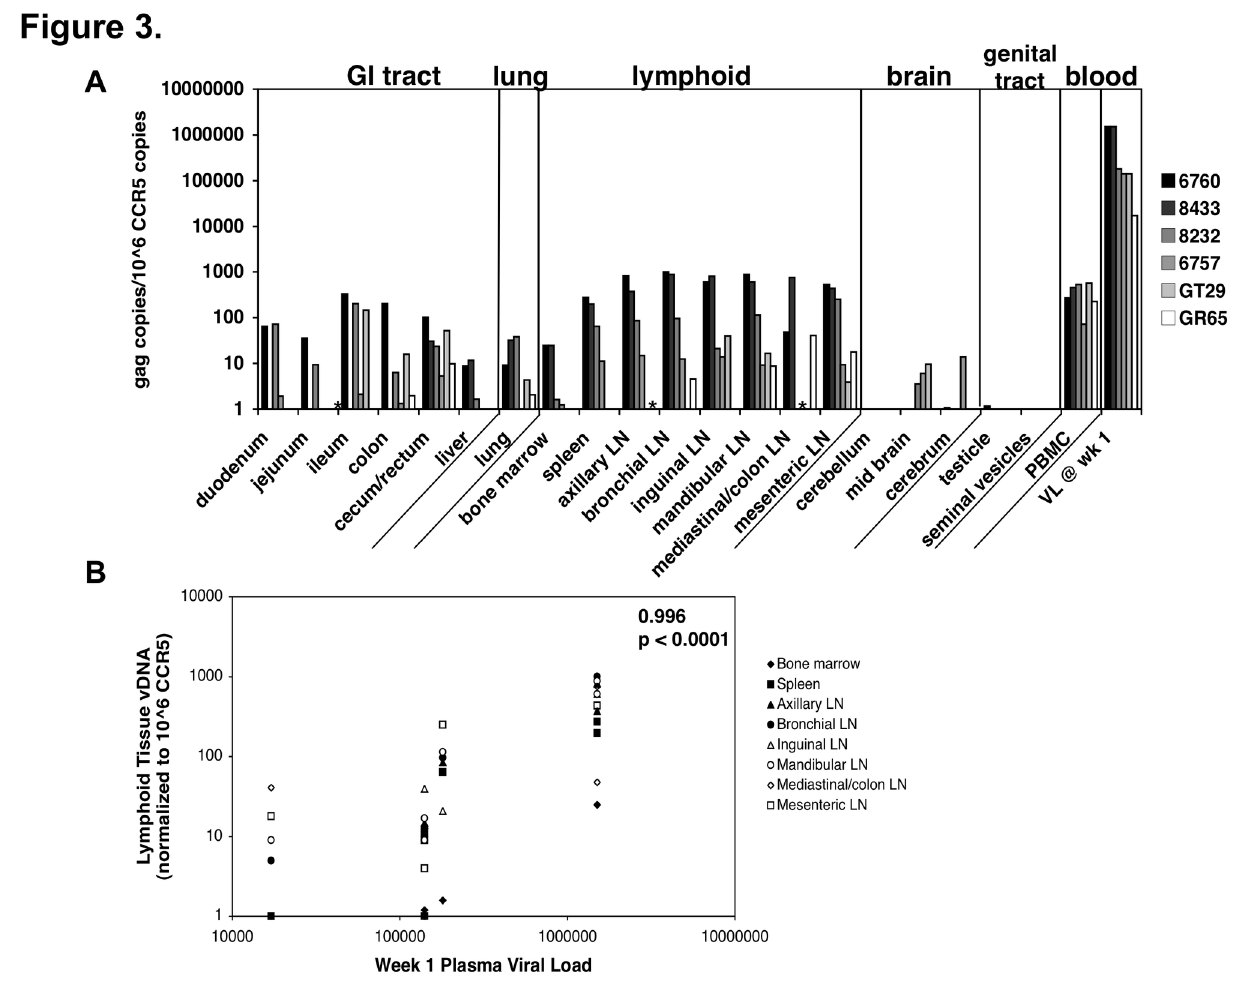
Figure 3. Lymphoid tissue viral DNA at necropsy is correlated with week 1 plasma viremia levels. (A) The ratio of gag copies per 10 6 CCR5 copies for each tissue of the untreated RT-SHIV-infected macaques. The average of each qPCR reaction was used for the graph. In addition, the week 1 plasma viral load was included for each animal. Asterisks (*) denote samples that were not collected or in which no significant CCR5 DNA were measured. (B) The amount of gag vDNA detected in each of the lymphoid tissues for each animal was plotted against the week 1 plasma viremia level. Statistics determined a Spearman rank-order correlation of 0.996 with p value of <